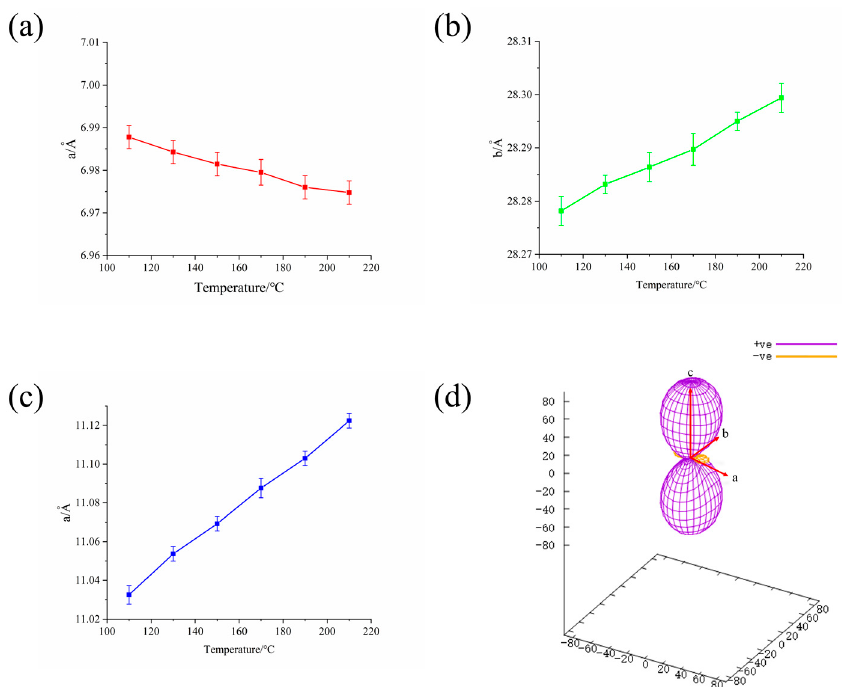
Figure 5. Temperature-dependent crystallographic parameters a ( a ), b ( b ) and c ( c ) axes and the expansivity indicatrices ( d ) of TMP-25HBA; purple and yellow represent positive and negative thermal expansion, respectively.